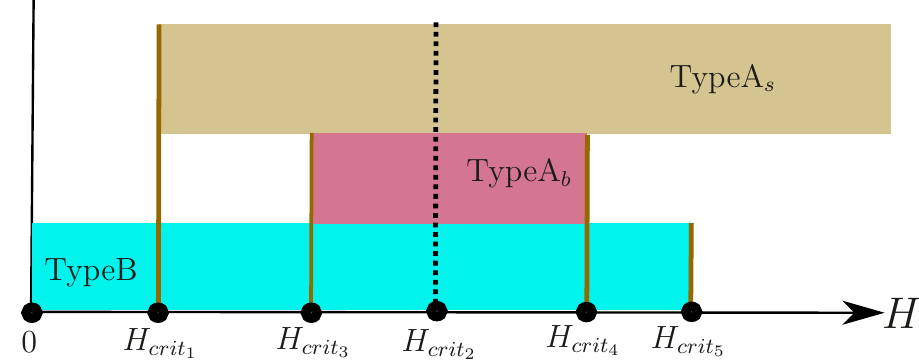
Figure 1 . de Sitter vacua (TypeB) and de Sitter DFPs (TypeA s and TypeA b ) of the cascading gauge theory with a fixed strong coupling scale Λ . The vertical brown lines indicate the existence range for different phases: TypeA exists for H ∈ ( H + ∞ ) ; TypeA exists for H ∈ ( H ) ; s crit 1 , b crit 3 , H crit 4 TypeB exists for H ∈ (0 , H ) . In the range H ∈ ( H ) , indicated by a vertical dashed crit 5 crit 3 , H crit 2 line, TypeA DFP is the preferred b